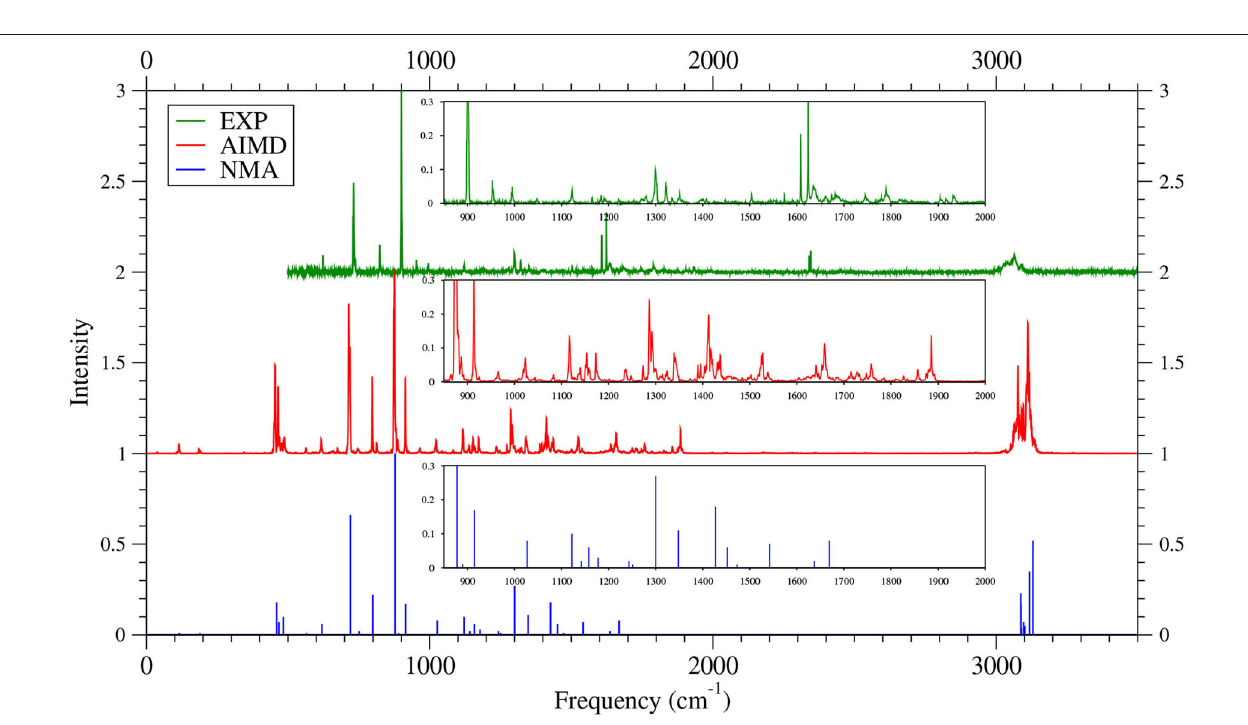
Frontiers in Chemistry |